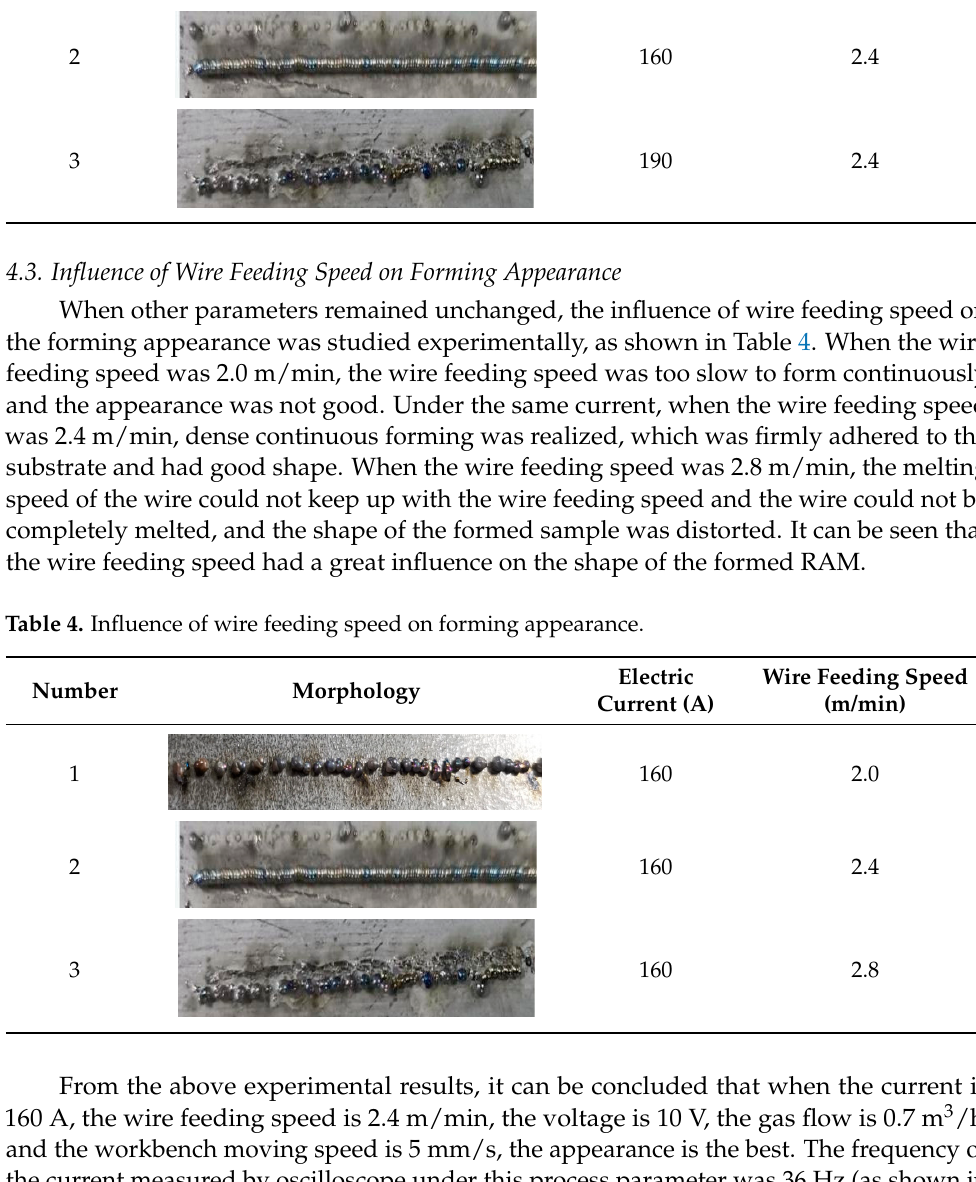
Table 4. Influence of wire feeding speed on forming appearance.